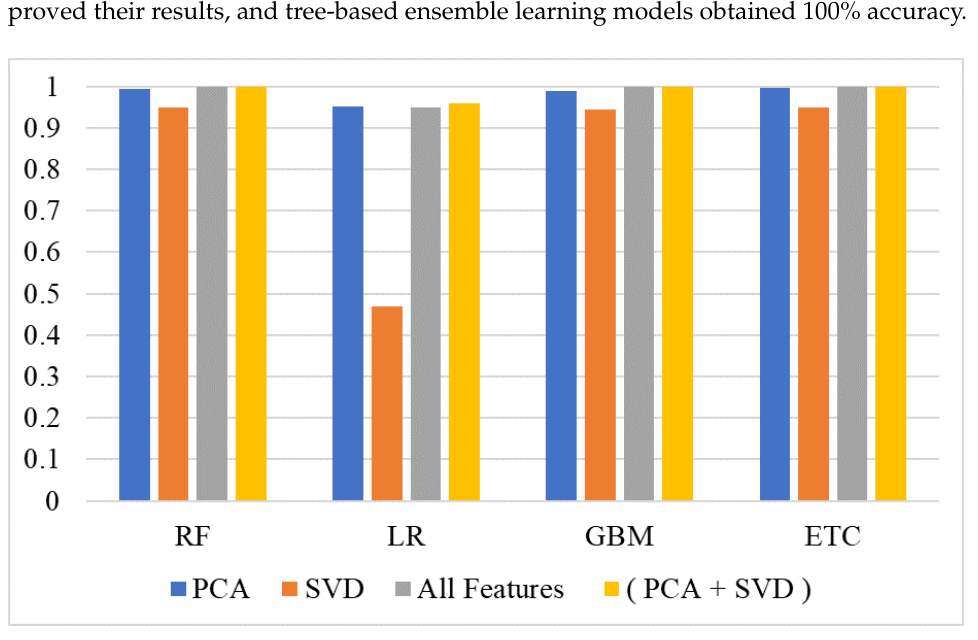
Figure 5. Models’ performance comparison using all features